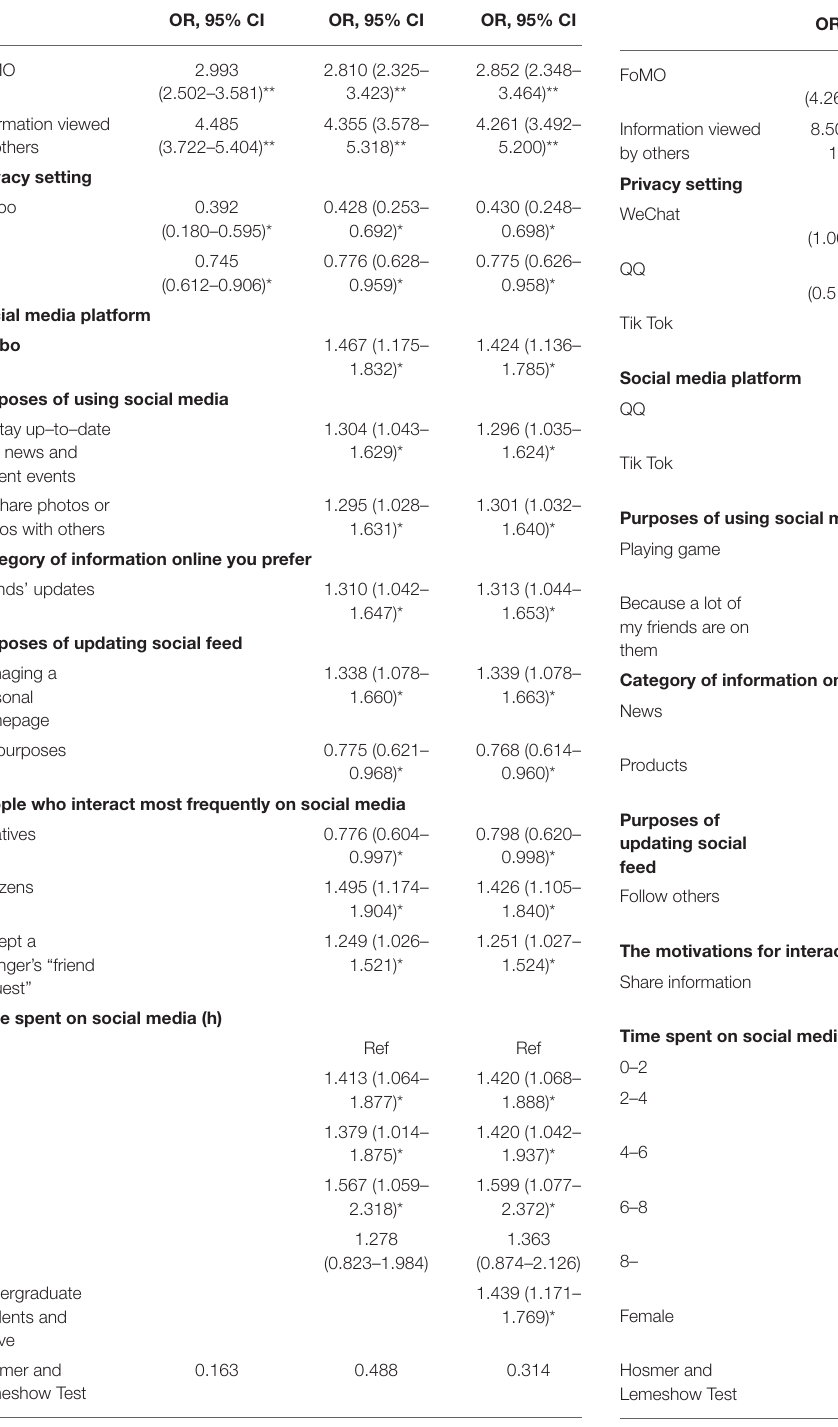
TABLE 2 | Factors associated with expression willingness among university students.